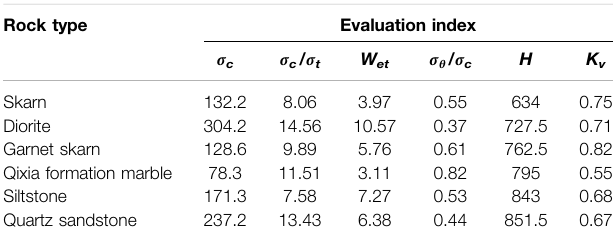
TABLE 9 | Rock burst tendency prediction value for the Dongguashan Copper Mine. Rock type